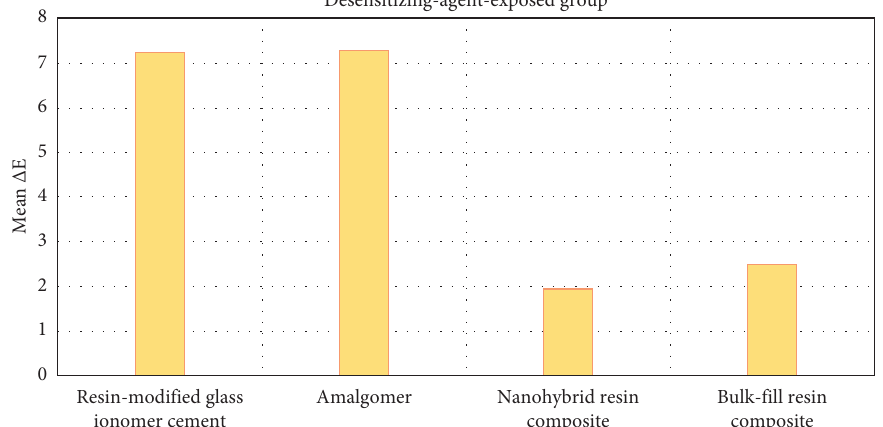
Figure 5: Graphical presentation of the color changes in desensitizing-agent-exposed groups of the tested materials.